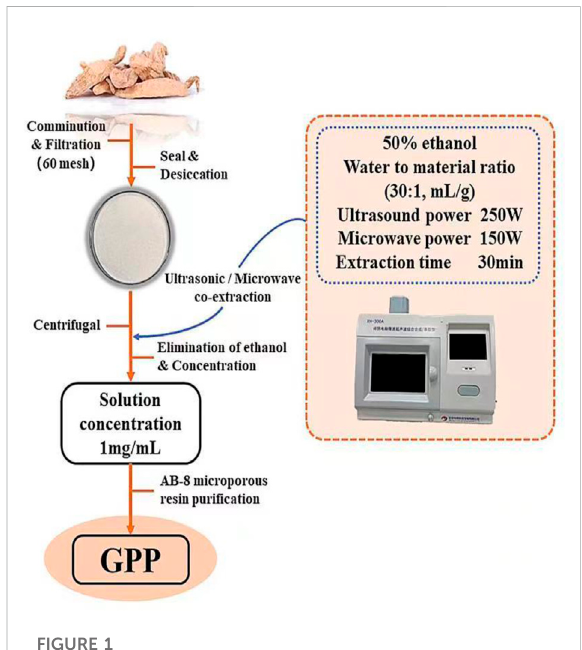
The extraction, isolation, and puri fi cation procedure of